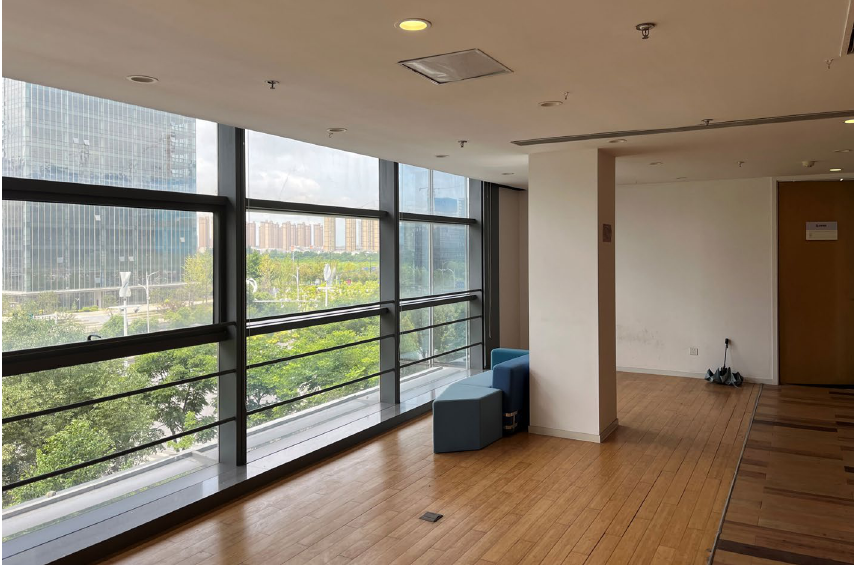
Fig. 3 An exemplary indoor environment with wood, plaster, and